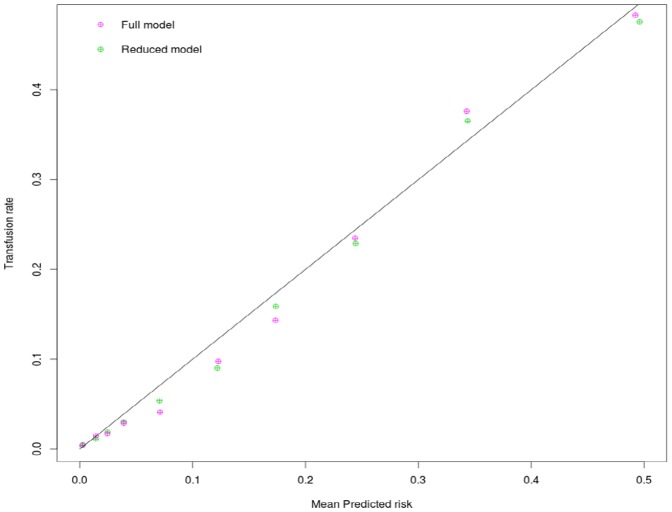
Calibration plot depicting observed transfusion across predicted risk using the full and the abbreviated model.